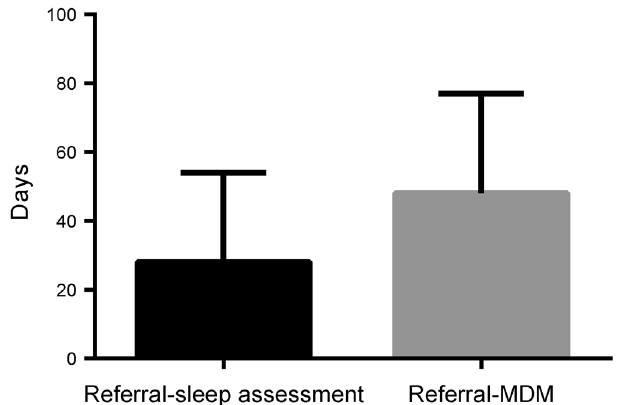
Fig. 2 Wait-times (median and interquartile range) from referral to sleep assessment and MDM in